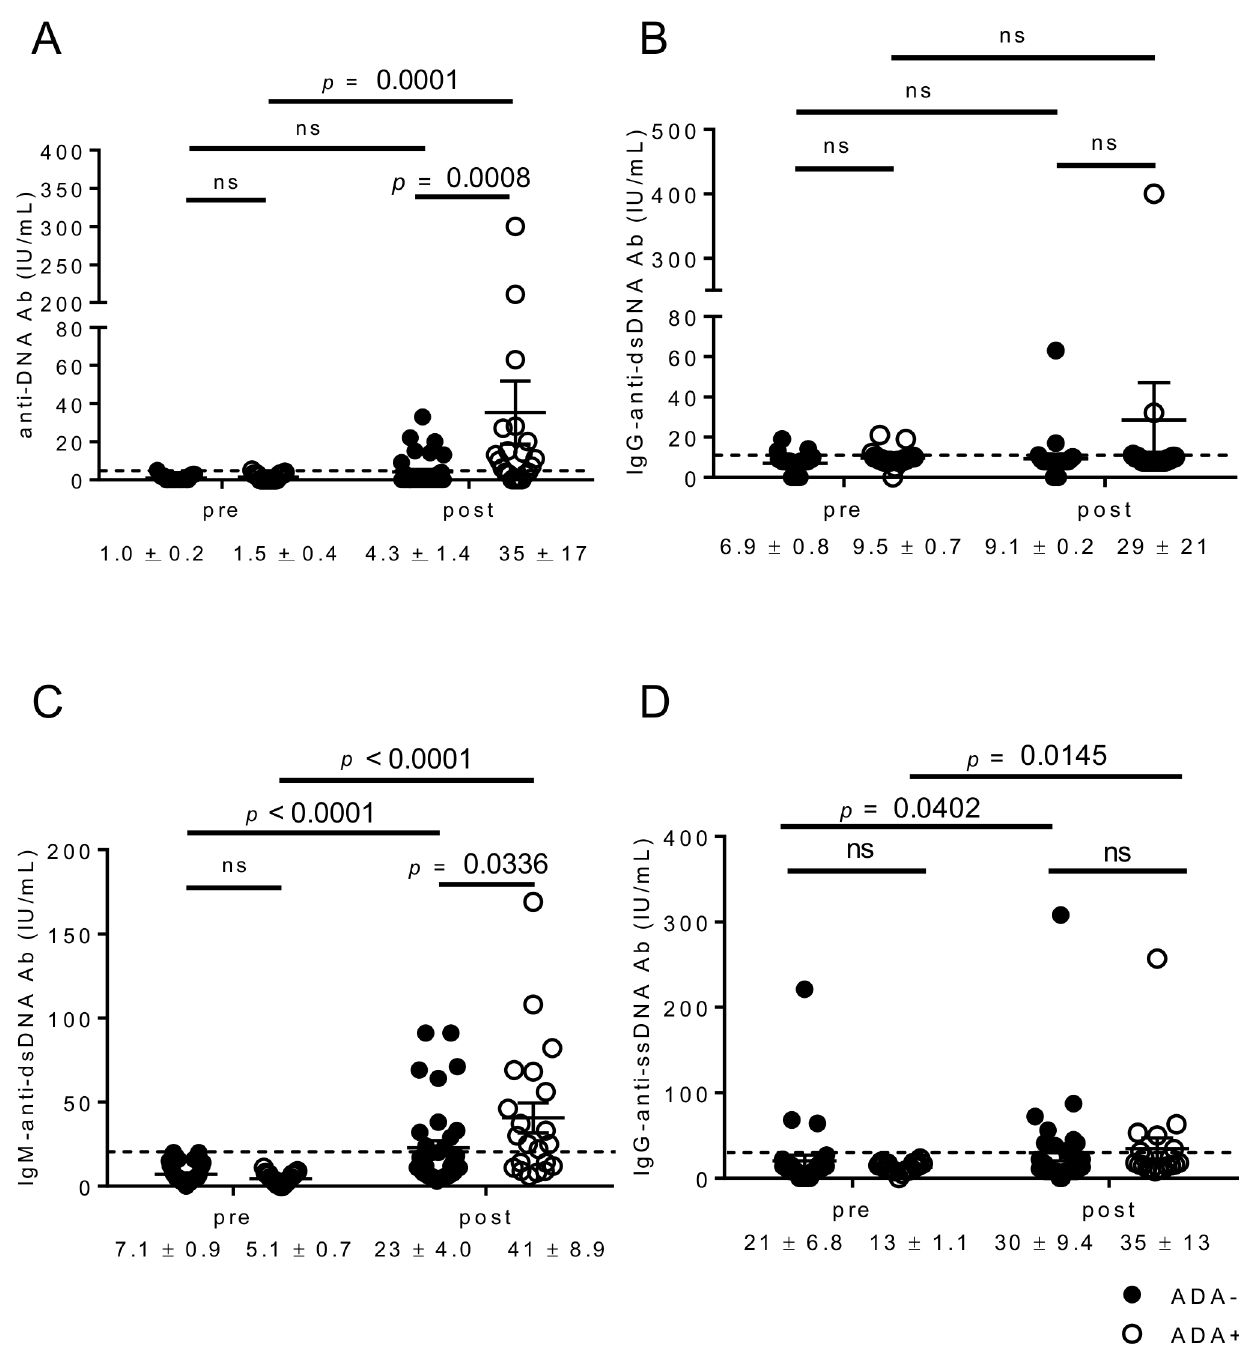
Fig 3. The association between ADA and anti-DNA Ab. The baseline (pre) and the peak (post) values of anti-DNA Ab (Farr) (A), IgG-anti- dsDNA Ab (B), IgM-anti-dsDNA Ab (C), and IgG-anti-ssDNA Ab (D). The upper limit normal values are indicated by dashed lines. The post values are the highest titers observed during the follow-up periods. Each dot represents a single serum sample, and the data are presented as mean ± SEM. A paired t -test for intra-group comparison or the Mann-Whitney test for inter-group comparison was used. ns: not significant.